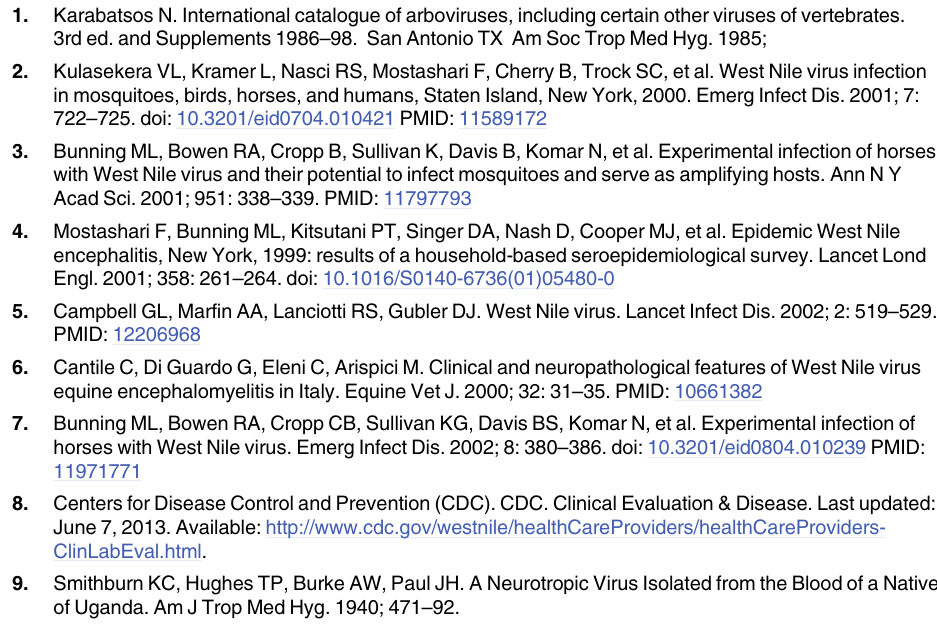
S1 Fig. Examples of the 23 MD values in each of the studied year and the spline interpola- tion in one point in Northern Italy (10.9863E, 45.4293N) — A- and one point in the desert of Algeria (1E, 31N)- B. The different scales are meant to highlight the differences in the MD values. S2 Fig. Standardized mosquito abundance across a year in three different points: desert in Algeria, Padan Plain and Apennine Chain (at an altitude of 1000 m). S1 Table. Minimal data set underlying the findings in the study. Data include equine clinical cases in Italy, Morocco Portugal and Greece; human cases in Tunisia. S2 Table. Formulas, parameters, initial values and references of the mosquito ’ s growth model: birth and mortality parameters in the ordinary differential equations